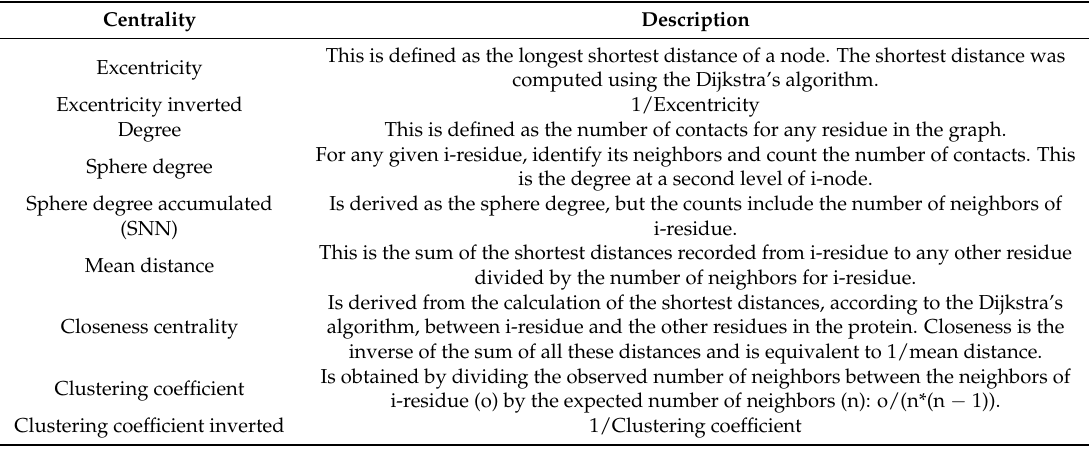
Table 10. Centrality measures used in this